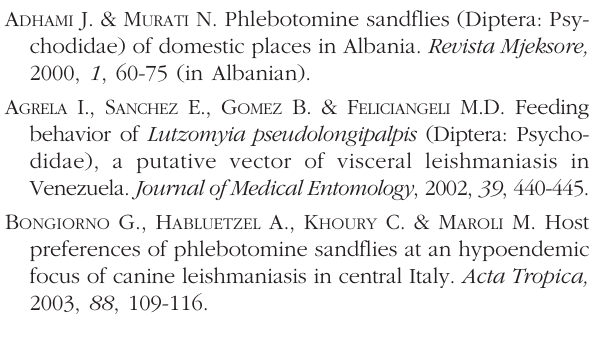
Table III. – Cumulative percentages of P. neglectus , P. perfiliewi and P. tobbi reacting with each anti-species reagent and the corresponding forage ratio (FR) and host selectivity index (HIS). A single P. papatasi specimen fed on bovine.